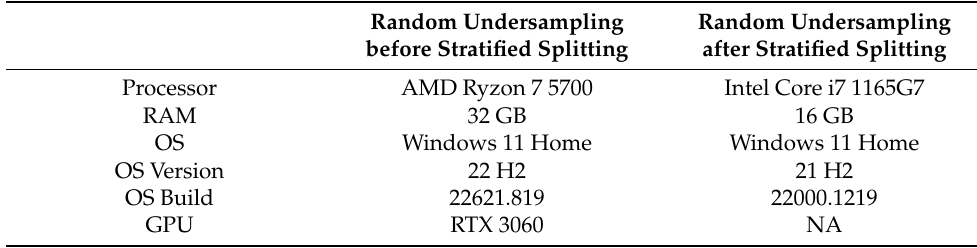
Random Undersampling